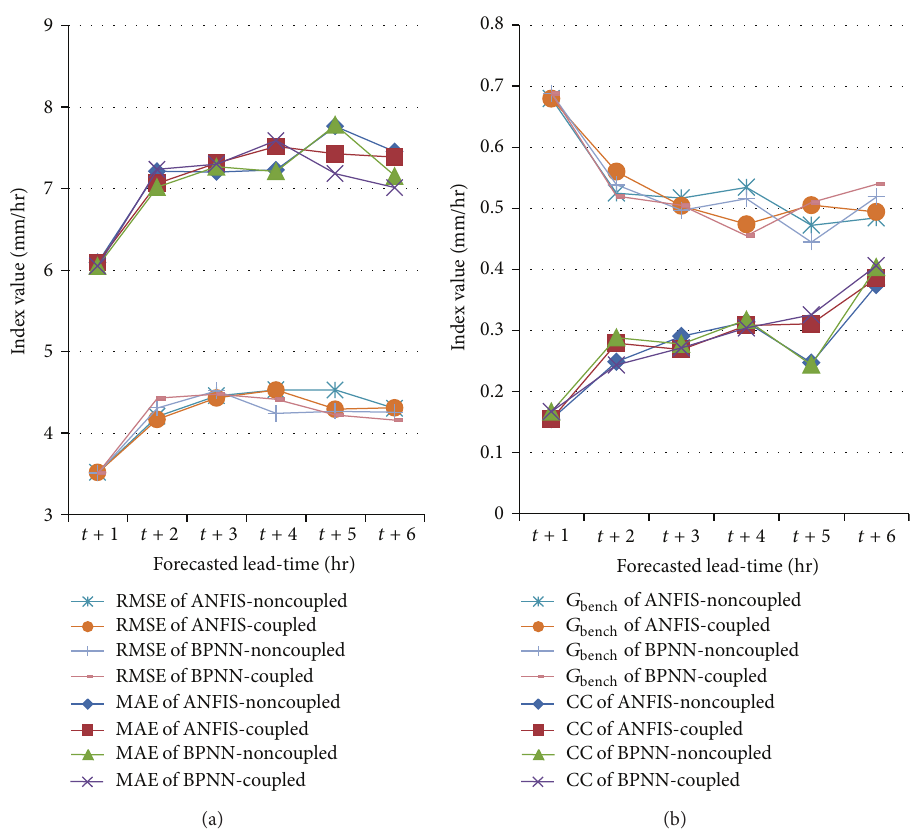
Figure 15: The testing index values of the coupled and noncoupled models at Hsia-Yun station: (a) MAE and RMSE; (b) CC and 𝐺